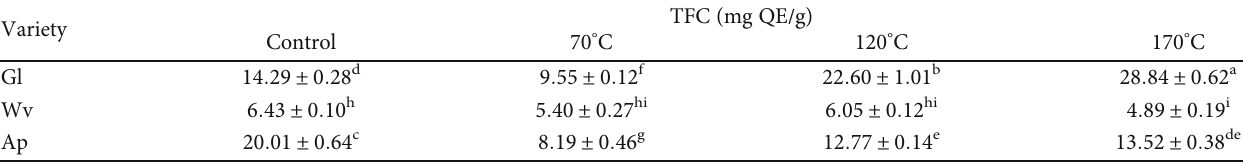
Table 3: Total fl avonoid content of thermally treated leafy vegetables (DW). Variety